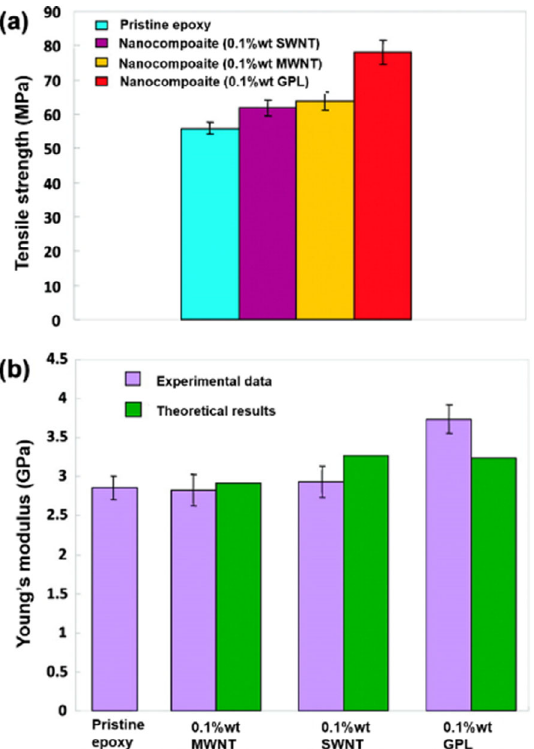
Fig. 5 (a) Tensile strength and (b) Y of pristine EP, single- walled carbon nanotube (SWNT)/EP, multi-walled carbon nanotube (MWNT)/EP, and graphene (GPL)/EP composites. Reproduced with permission from Ref. [117], © American Chemical Society 2009.